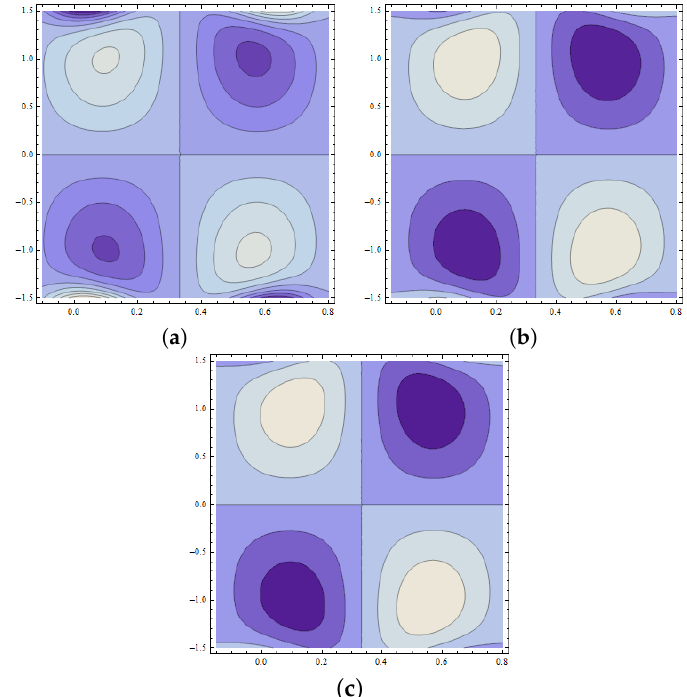
Figure 21. Pattern of streamlines when (cid:101) = 0.1, t = 0.1, m = 0.04, m 1 = 2, E 1 = 0.2, E 2 = 0.2, E 3 = 0.3 and n = 0.4 with ( a ) We = 0.4, ( b ) We = 0.2, ( c ) We =